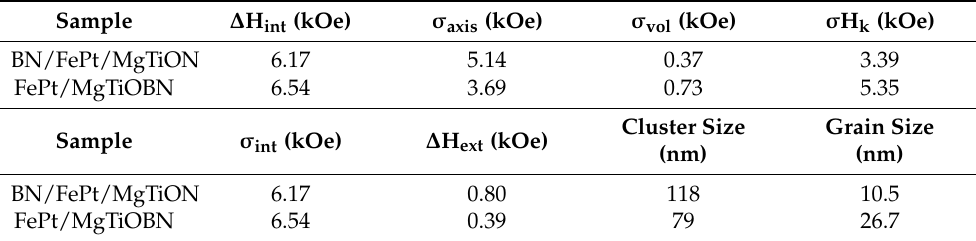
Table 1. Magnetic switching field behaviors of FePtCAg/MgTiOBN film and BN/FePtCAg/MgTiON (reference